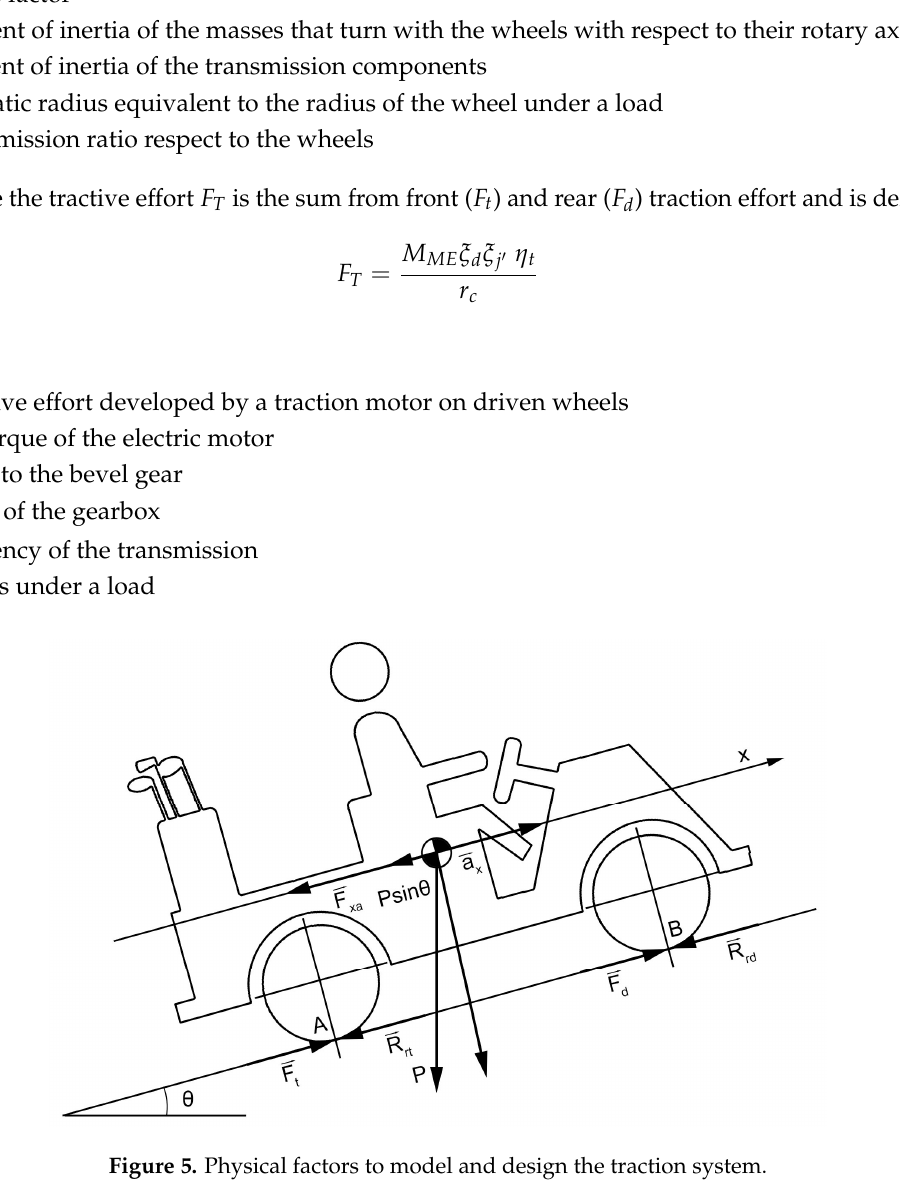
Table 3. Specifications of golf car.